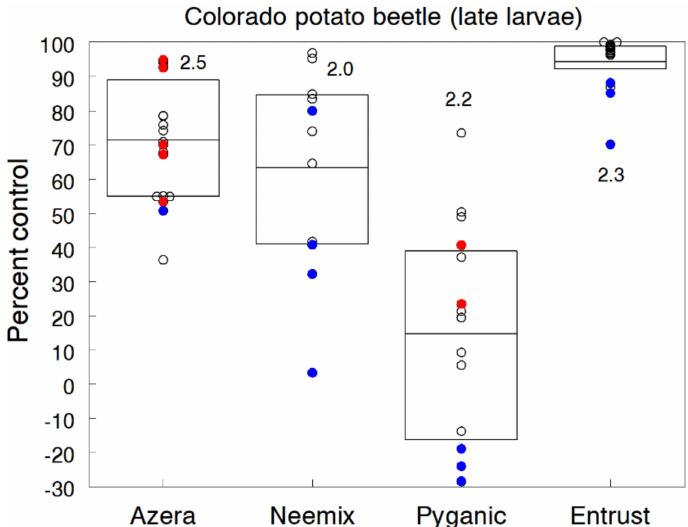
Figure 9. Percent control of Colorado potato beetle with weekly applications of Azera, Neemix, PyGanic and Entrust relative to the untreated control. Mean data are given for larvae (3rd and 4th instars) compiled from 14 trials on potato. Box-whisker plots show the 25% and 75% percentile range of percent control data and the horizontal line in each box is the overall mean control e ffi cacy. Number above each plot indicates the average number of weekly applications. Application rates of Azera, Neemix, PyGanic and Entrust were 2.34 L / h, 1169 mL / h, 2.34 L / h and 71.2 g a.i. / h respectively, except for individual trial data in blue and red indicating lower and higher rates, respectively. Azera, Neemix and Entrust provided significantly higher control of adults compared to